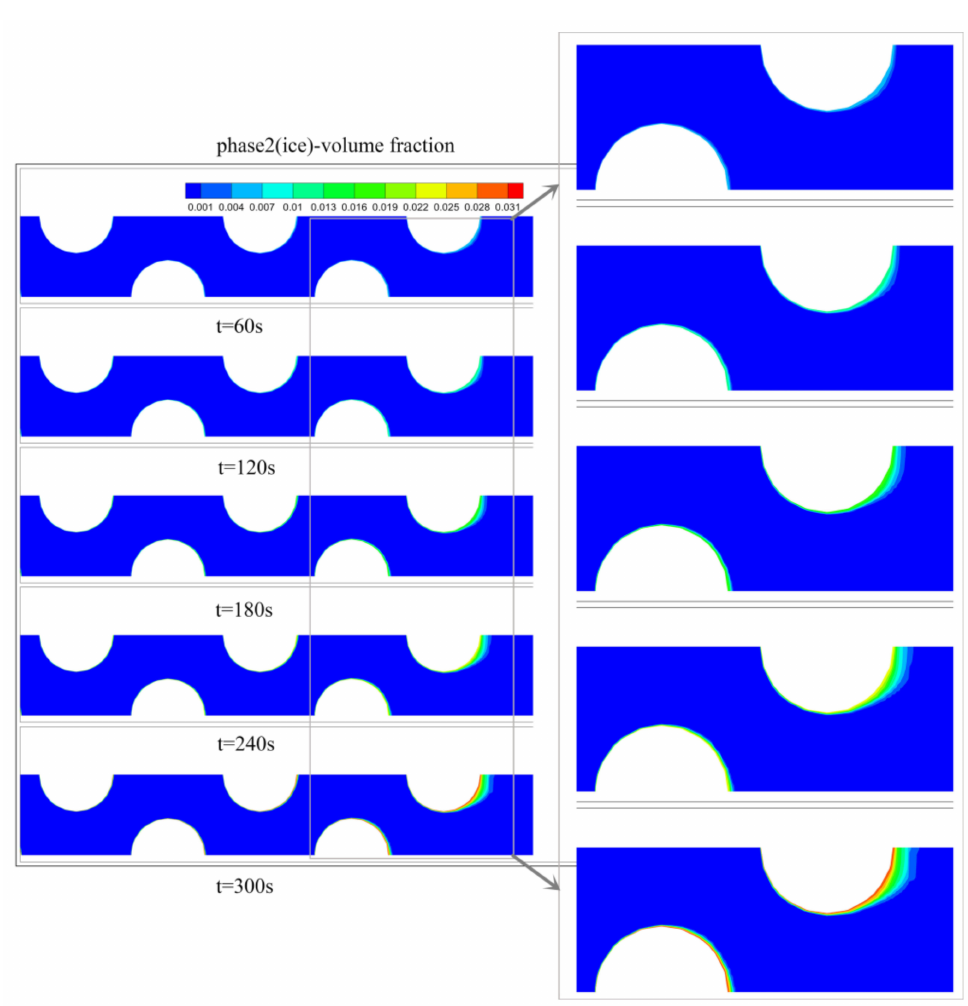
Figure 12. Variation of frost morphology on the tube